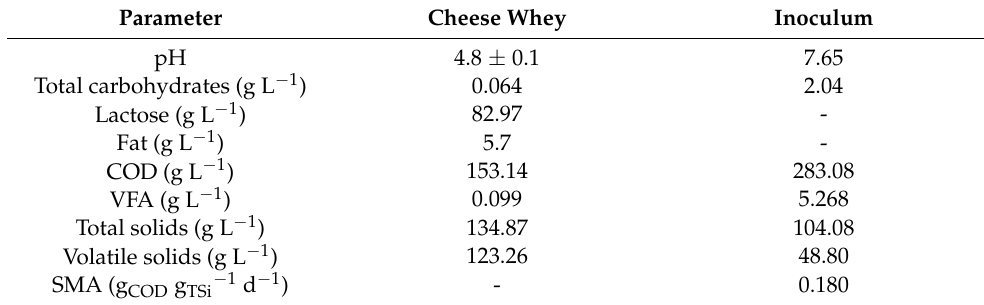
Table 1. Physicochemical parameters of raw cheese whey and inoculum used in experimental